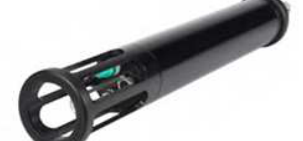
Figure 3. Sound velocity profiler AML SV Plus V2, used for the cruise.